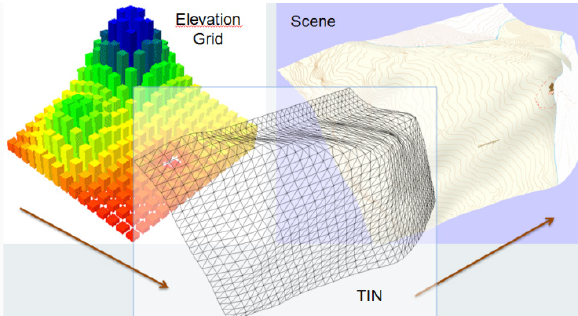
Figure 11: Combination of a TIN and a Map image makes an interactive